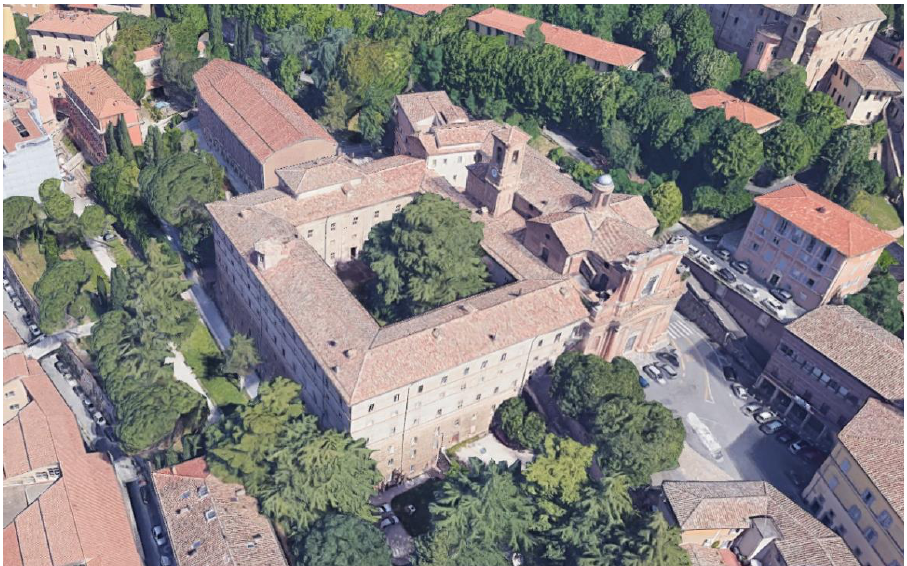
Figure 1. Current view of complex of Murena Palace in Perugia, Italy. Reworked from Google Maps, cartographic data (2020).